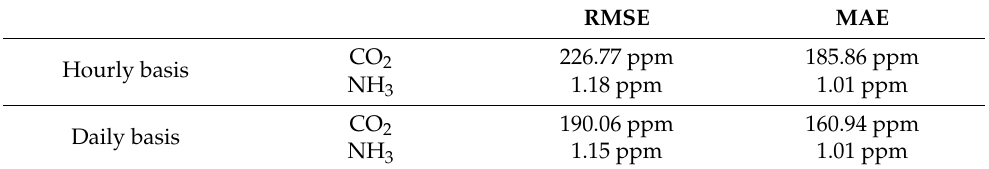
Table 10. Statistical indices for evaluating the goodness-of-fit of the model in terms of CO 2 and NH 3